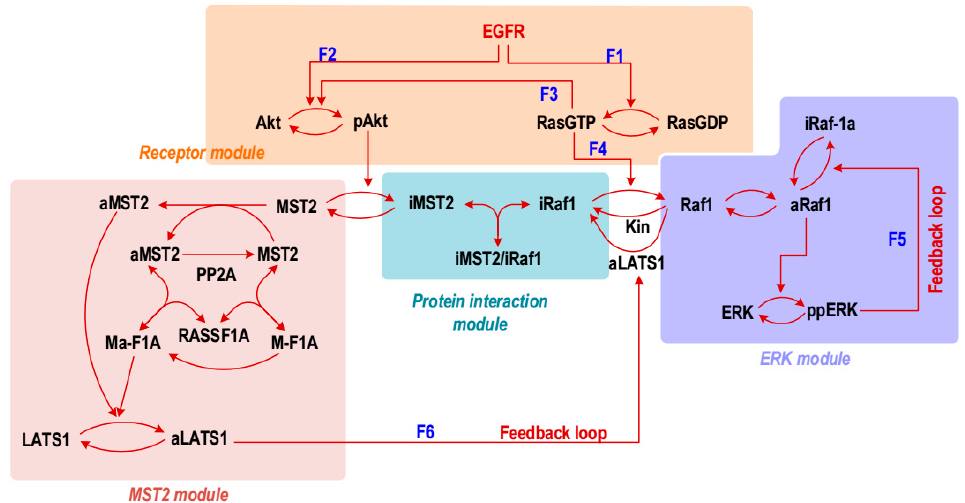
Figure 1. Schematic diagram of the Hippo-ERK network showing the molecular species and the reactant proteins involved in binding and (de)phosphorylation reactions: aRaf1, active Raf-1 phosphorylated at Serine 338; iRaf1, inactive Raf-1 phosphorylated at Serine 259; iMST2, inactive MST2 phosphorylated by Akt; aMST2, active MST2; iMST2/iRaf1, iMST2-iRaf1 complex; M-F1A, RASSF1A-MST2 complex; Ma-F1A, aMST2-RASSF1A complex; aLATS1, active LATS1; ppERK, double-phosphorylated, high-activity ERK; pAkt, phosphorylated, activated Akt; Kin, kinases other than LATS1 phosphorylating Raf-1 on Serine 259. F 1 –F 6 indicate the crosstalk and feedback regulations of the ERK and MST2 pathways.